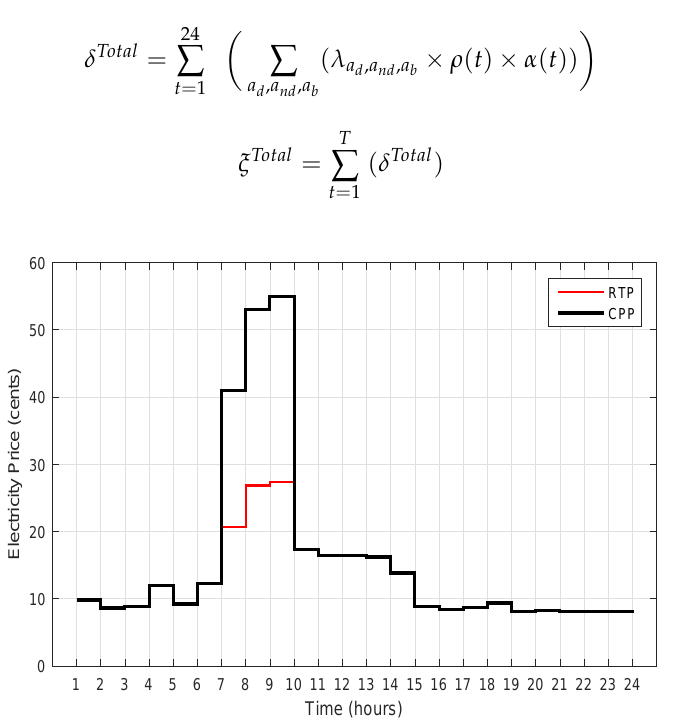
Figure 3. Pricing signals. CPP, Critical Peak